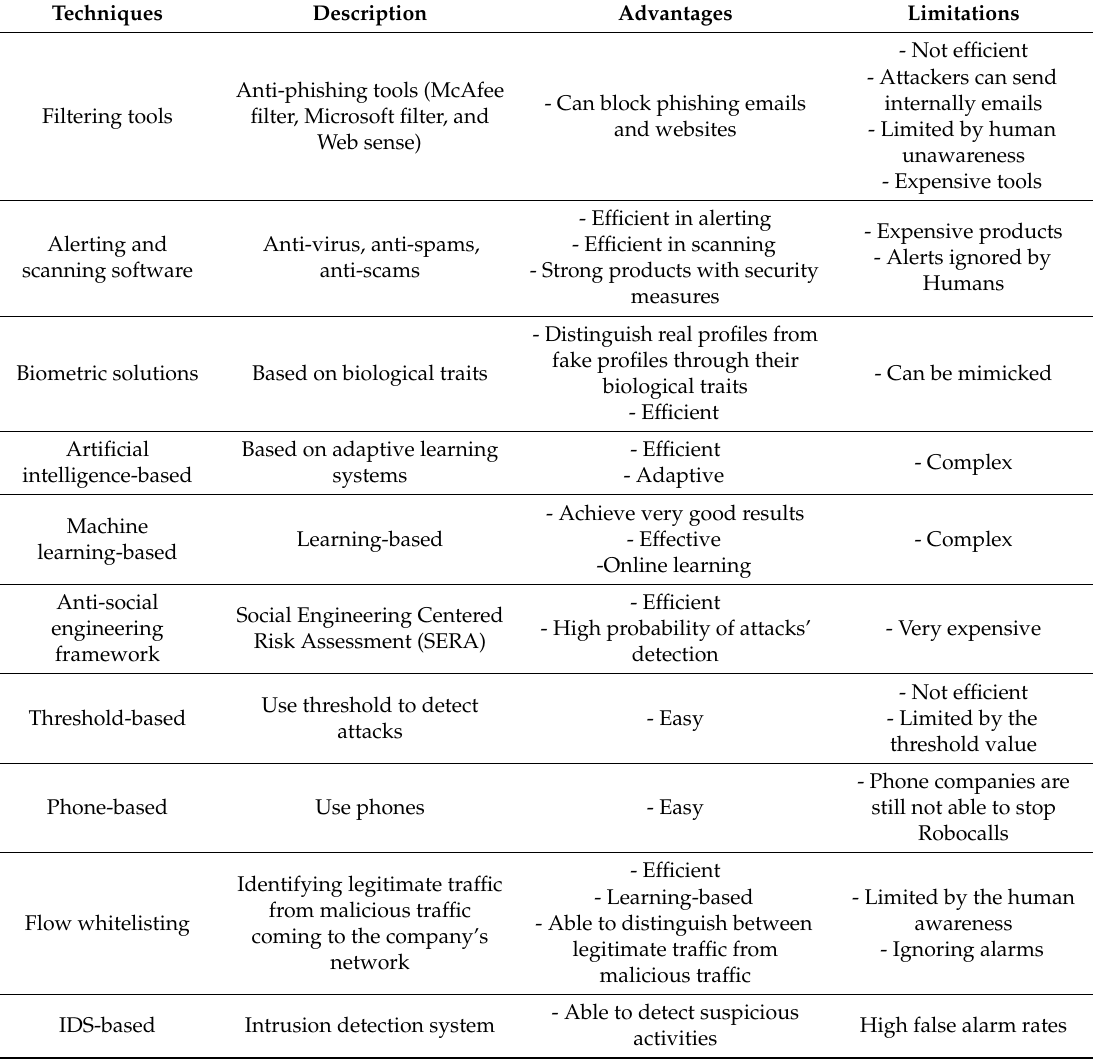
Table 2. Computer-based countermeasures and mitigation techniques